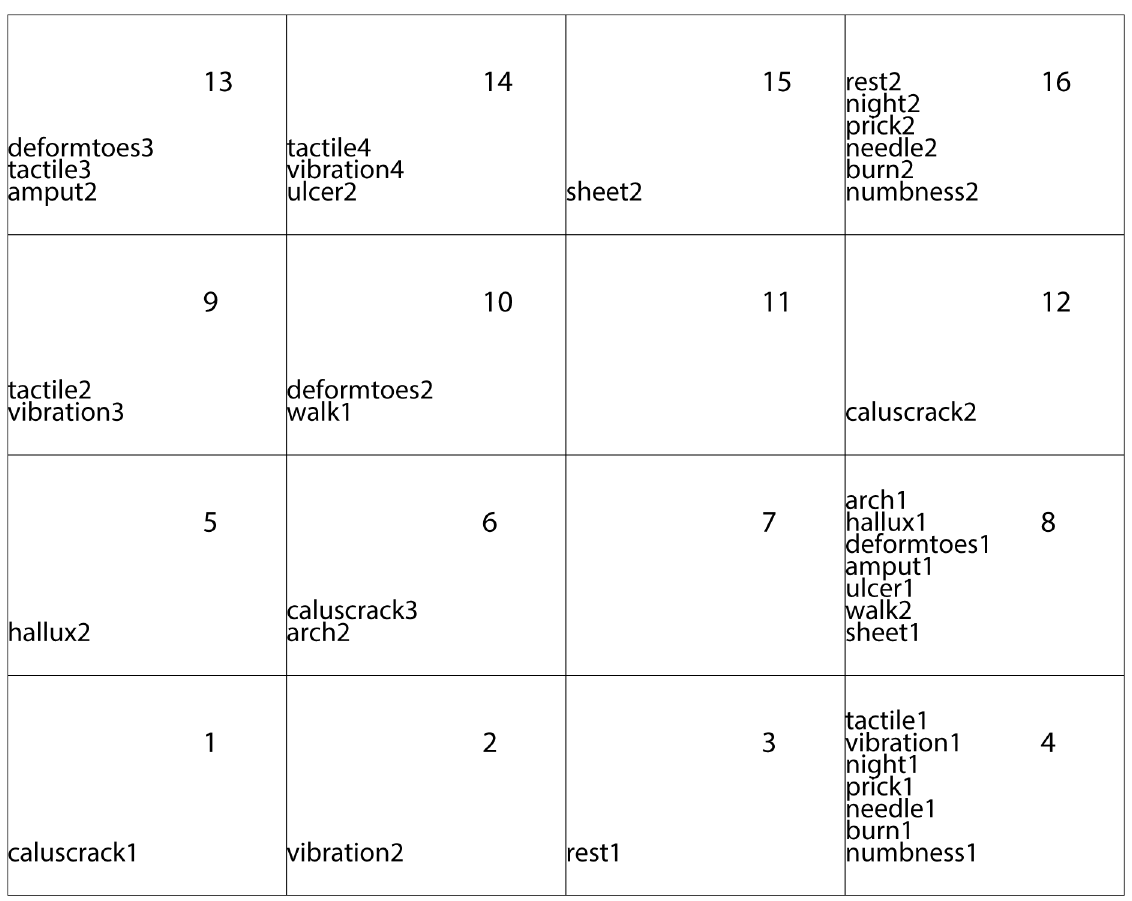
Fig 2. Repartition of the 39 modalities on the Kohonen map with 500